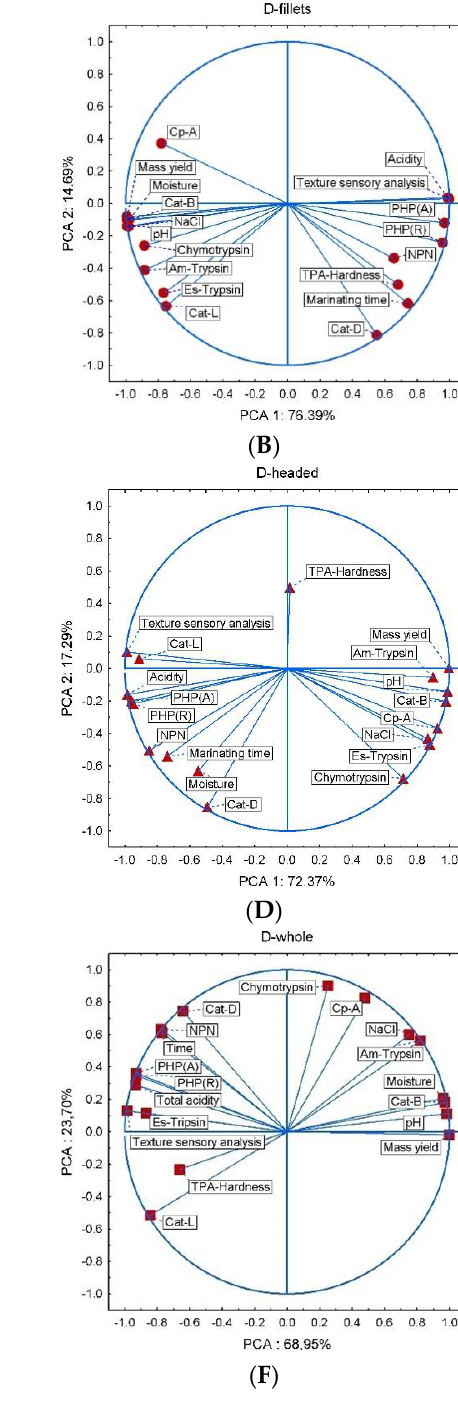
Figure 3. PCA biplot for correlations between protease activity, physicochemical parameters and sensory analyses of marinades depending on marinating methods: ( A , C , E ) German method (G-), ( B , D , F ) Danish method (D-) and depending on degree of primary processing of Baltic herring: ( A , B ), fillets of herring, ( C , D ) headed herring and ( E , F ) whole herring.